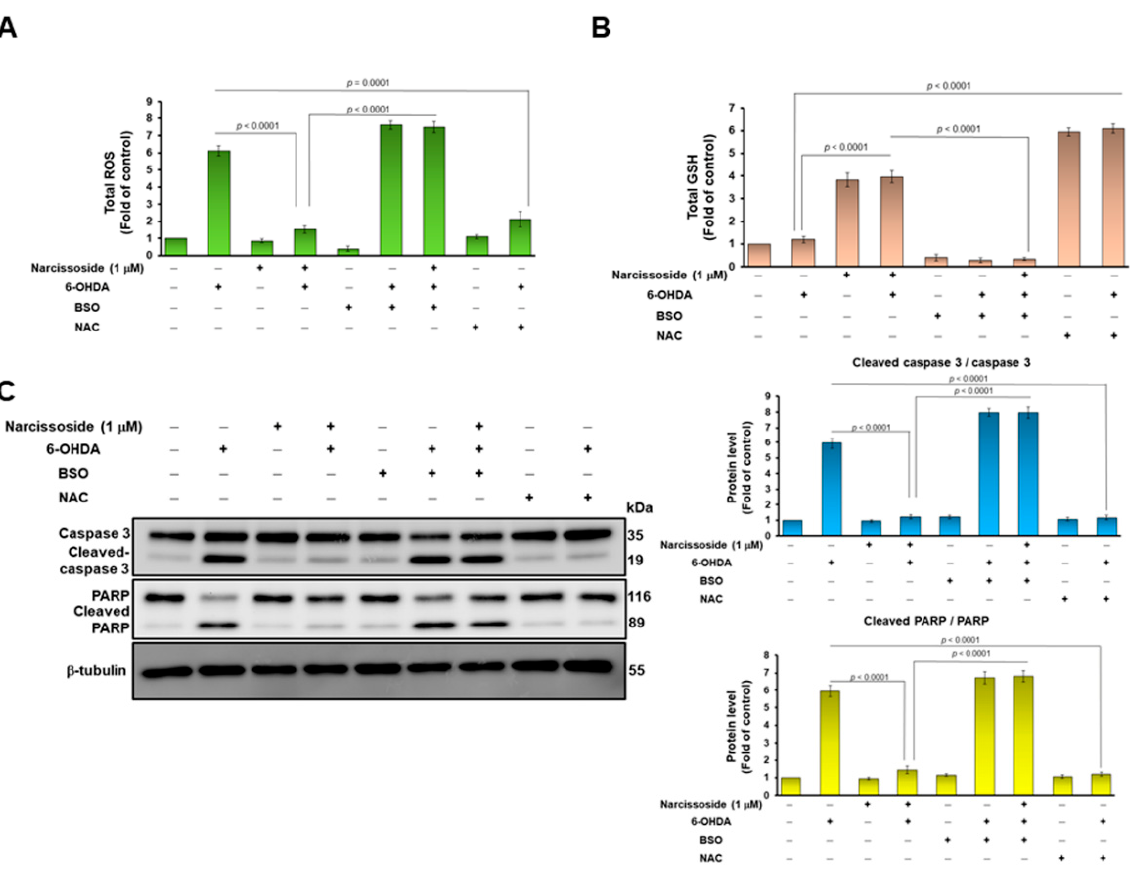
Figure 4. Treatment with the GSH inhibitor butthionine sulfoximine (BSO) reversed the ability of narcissoside (NCS) to inhibit 6-OHDA-induced ROS production and expression of apoptosis-related proteins in SH-SY5Y cells. BSO (100 µ M) or NAC (1 mM) was added to SH-SY5Y cells 1 h before NCS pretreatment. Then, cells were incubated with NCS (1 µ M) for 24 h, followed by treating them